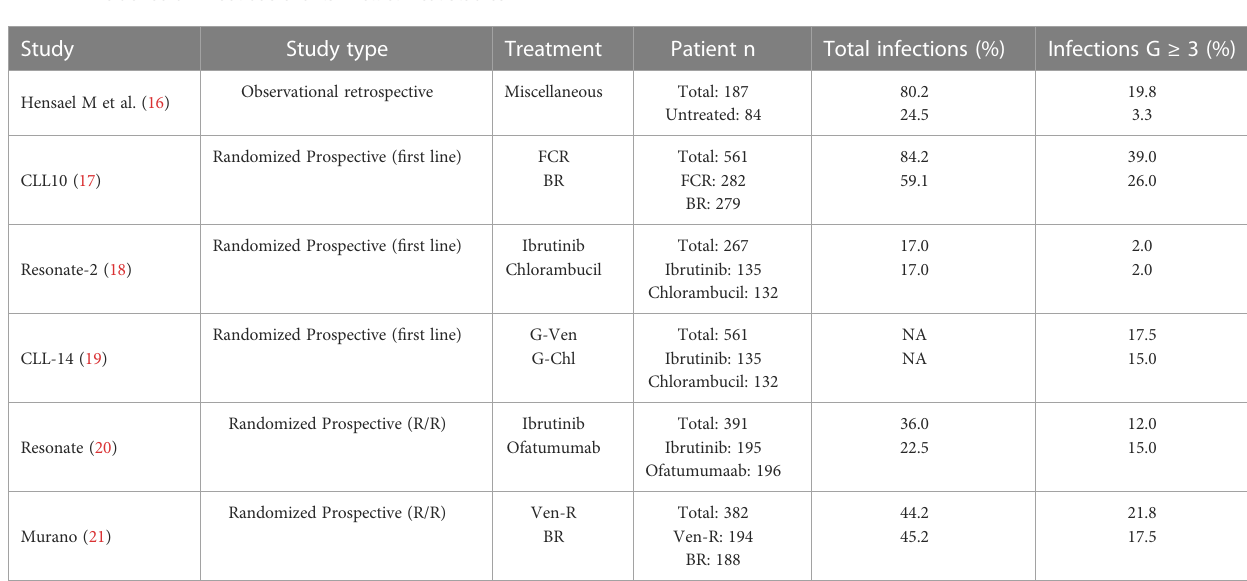
TABLE 1 Incidence of infectious events in cll clinical